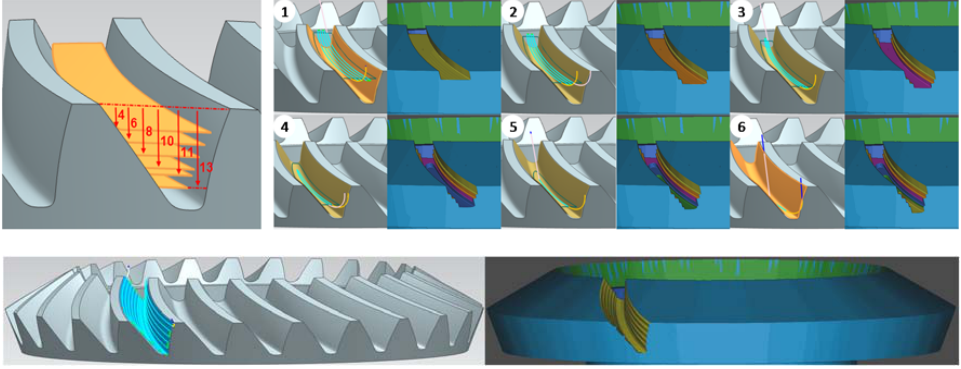
Figure 8. R ‐ III roughing strategy. Strategy axial depth progress is shown in 1–6.